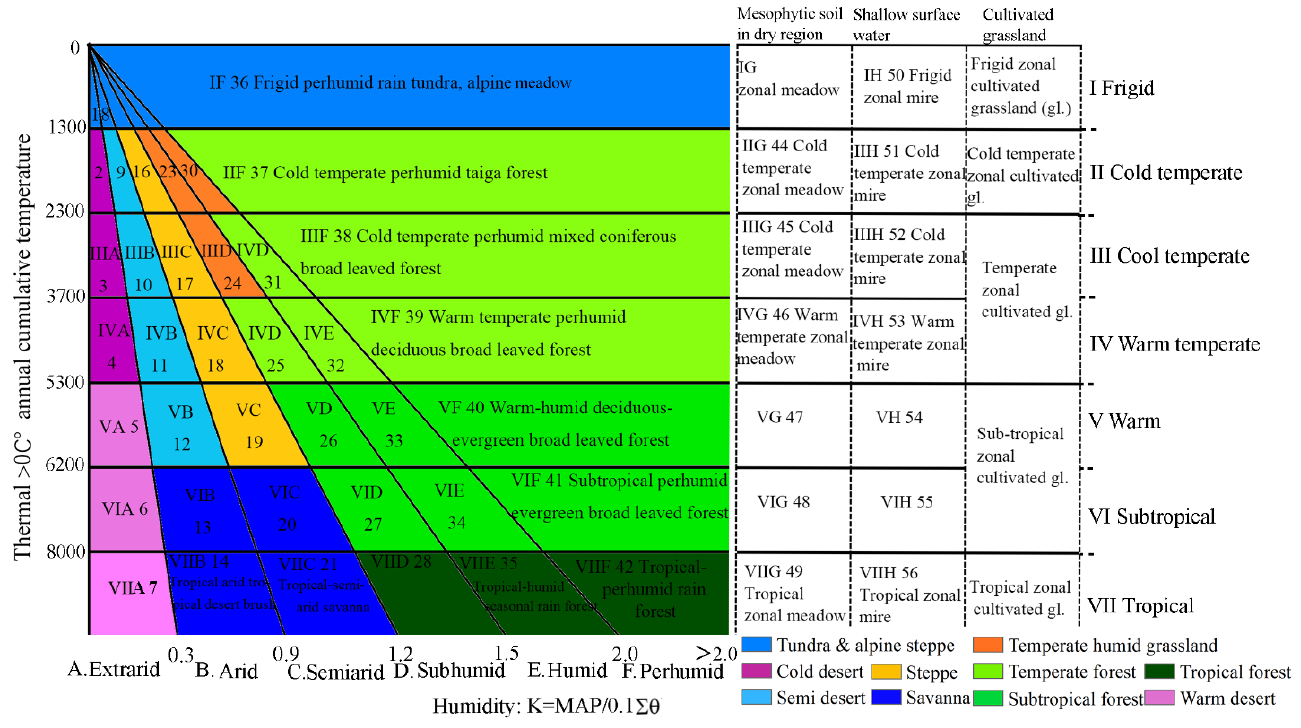
Figure 3. Index chart in the CSCS model.